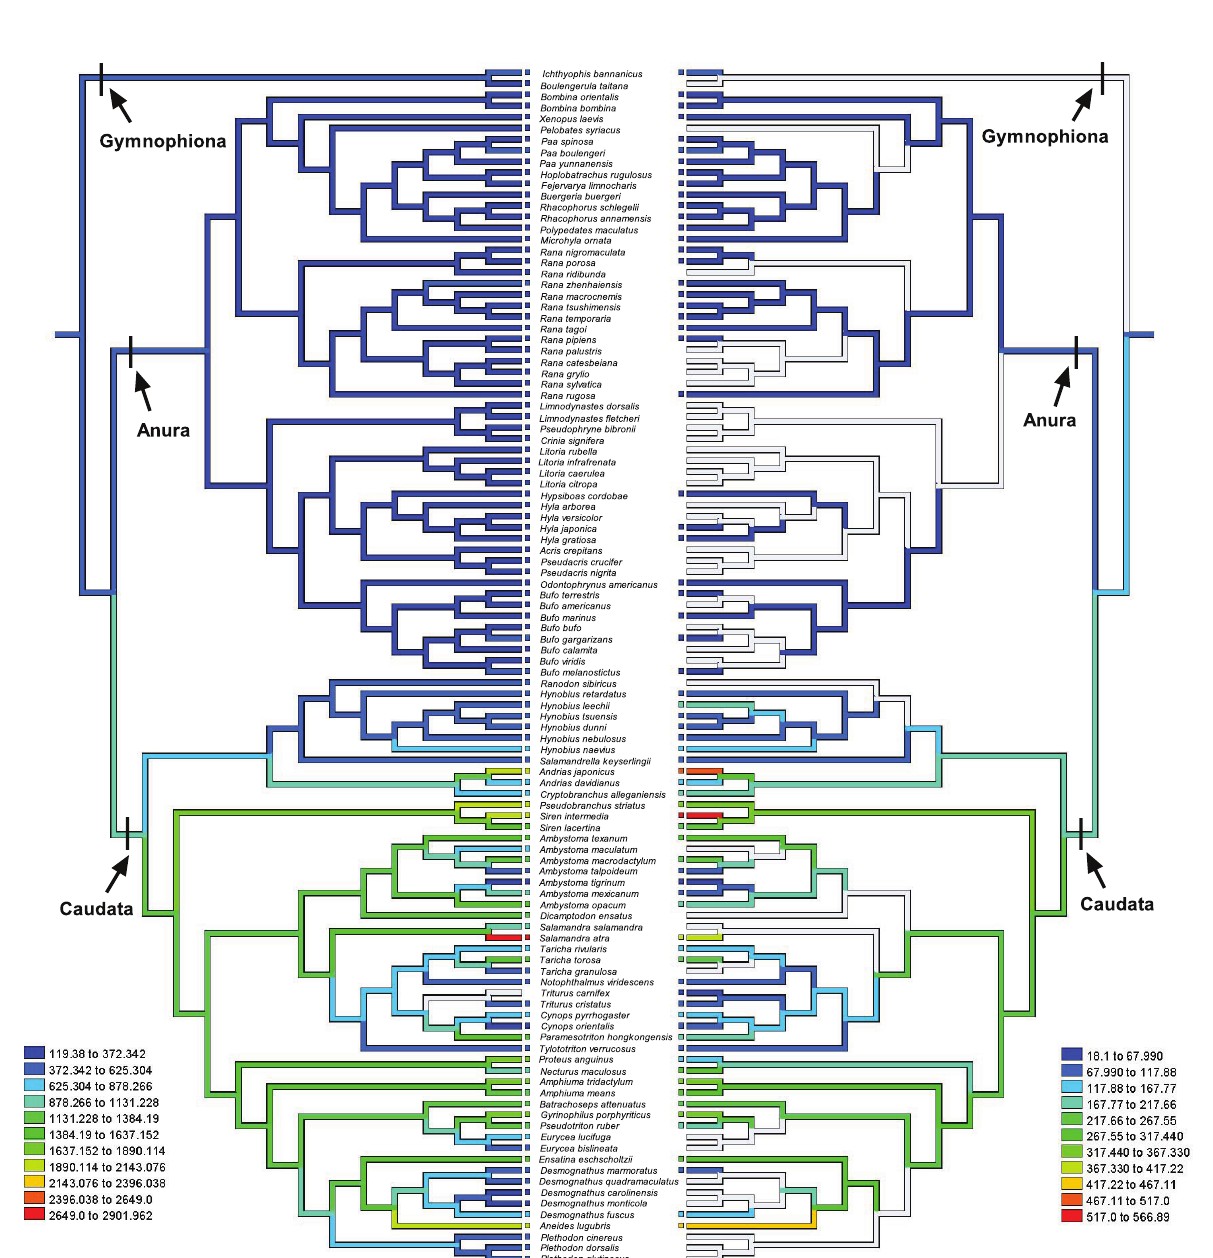
Figure 3 Mirror trees of the evolutionary history reconstructions of erythrocyte size (left side) and nucleus size (right side) of amphibians (blank branch is lack of data), according to phylogenetic hypotheses of P YRON & W IENS